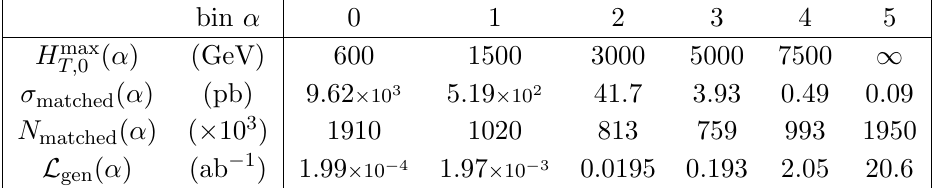
Table 11. Same as in table 10 but for the W -boson production